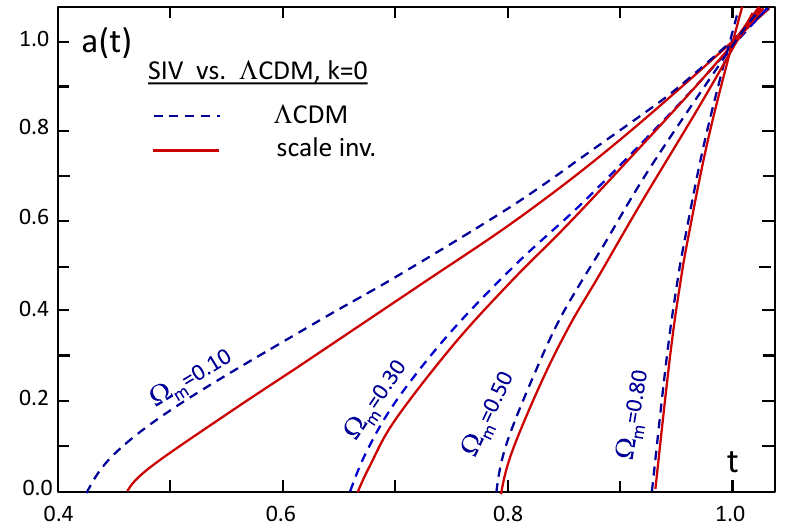
Figure 2. Comparisons of the a ( t ) functions of the Λ CDM and scale invariant models for given values of Ω m